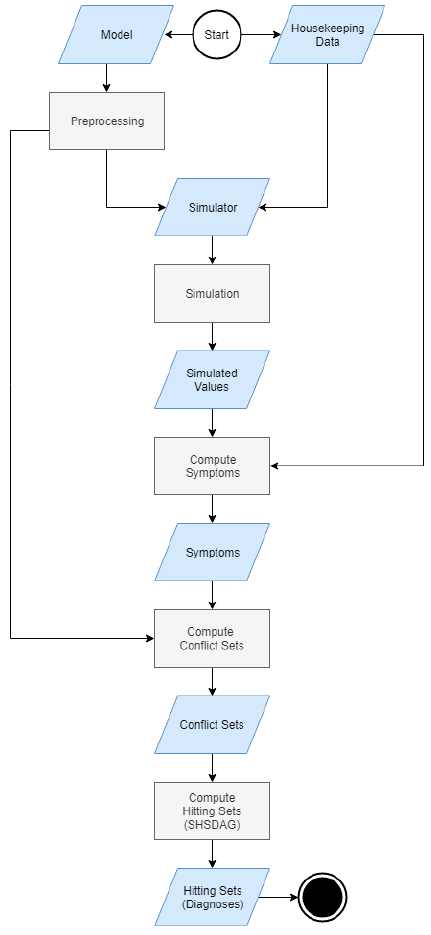
Figure 3. Overview of the different steps performed during fault detection and diagnosis.